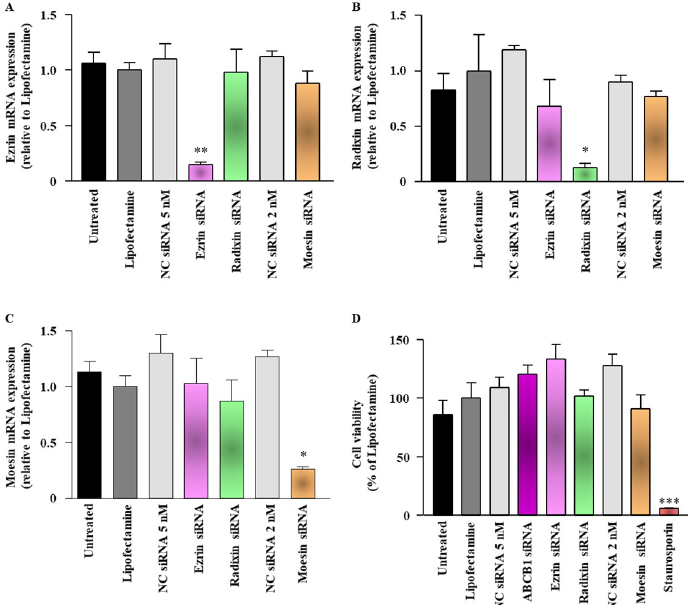
Fig 4. Effect of siRNAs targeting ezrin, radixin, or moesin on the mRNA expression of ezrin, radixin, and moesin (ERM) in LS180 cells under the acidic condition. Cells were treated with the transfection medium (Untreated), transfection reagent (Lipofectamine), nontargeting control (NC) siRNA, and specific siRNAs for ezrin, radixin, or moesin and then incubated for 3 days under the acidic condition with pH 6.5. (A–C) Expression of each mRNA in the cells treated with siRNAs relative to that in cells treated with the transfection reagent alone was measured by real-time quantitative reverse transcription-polymerase chain reaction. n = 3, �� p < 0.01, � p < 0.05 vs. Lipofectamine. (D) Cell viability was assessed with the PrestoBlue cell viability reagent. Staurosporine was used as a positive control for inducing cell death. n = 6, ��� p < 0.001 vs. Lipofectamine. All data are expressed as the mean ± SEM and were analyzed by one-way ANOVA followed by Tukey’s